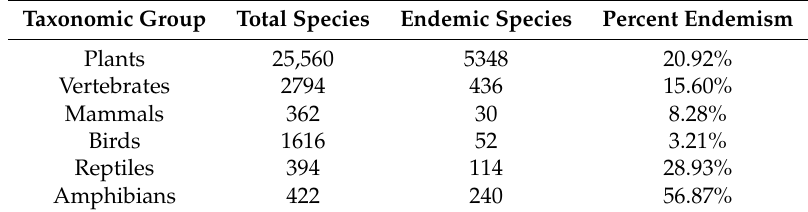
Table 1. The species diversity of various taxonomic groups in Ecuador